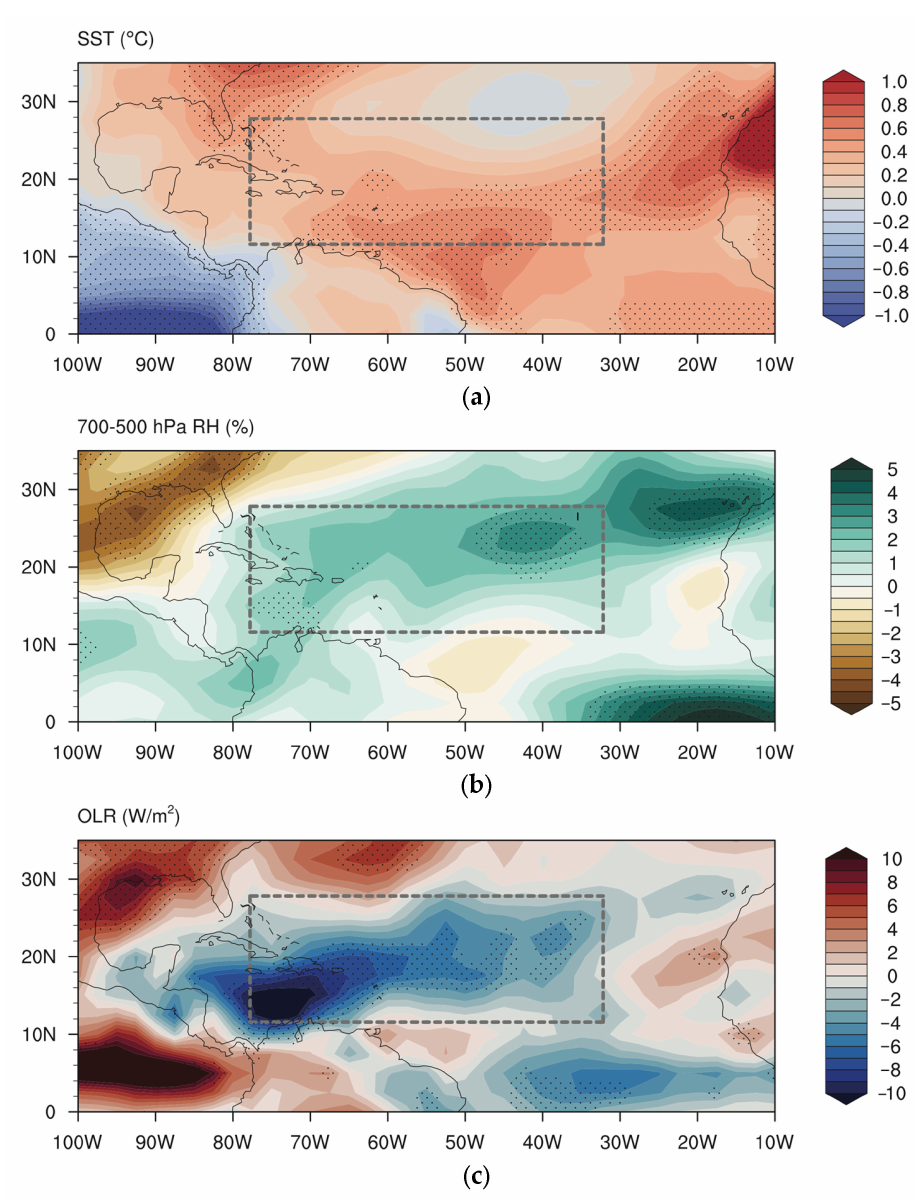
Figure 6. Composite differences of ( a ) sea surface temperature, ( b ) mid-tropospheric relative humidity, and ( c ) outgoing longwave radiation between the STC-active and -inactive years. Dotted areas indicate the differences are statistically significant at a 95% confidence level constructed which were by the 1000-sample bootstrap. Dashed lines indicate the potential genesis areas of the new TCs associated with the STC events between average ensemble with top 3 models and that with all 9